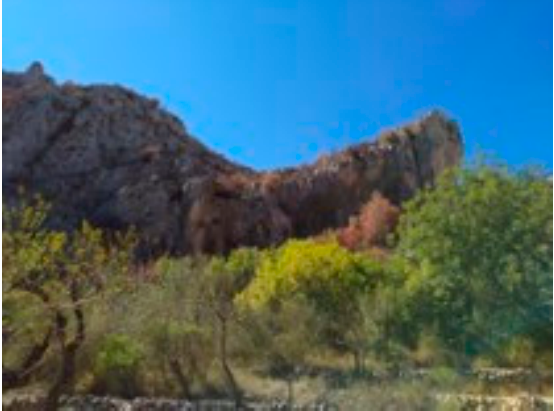
Figure 11. Concave shape, with “raised arms” on the side of the mountain in front of the shelter. The photo is taken by the author.